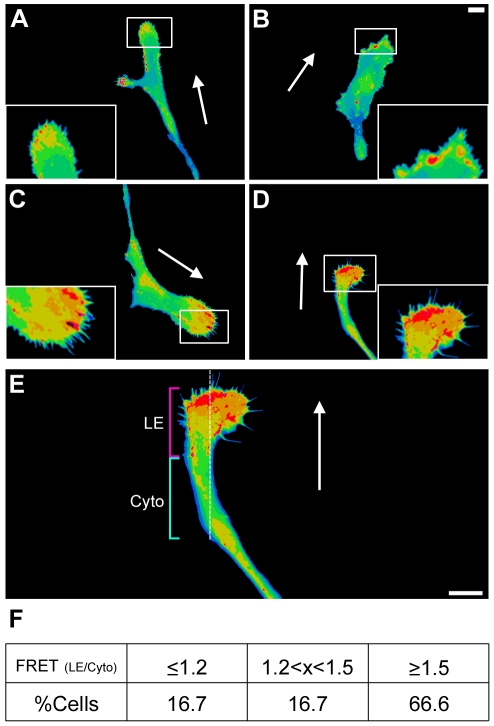
PKA is activated at the leading edge of invading SKOV-3 cells.(A-D) SKOV-3 cells transiently expressing pmAKAR3 were subject to the donut invasion assay and images of cells on the monolayer periphery were acquired 10 h after gasket removal. Pseudocolored FRET images are shown, with insets depicting enlargements of the areas indicated by the white rectangles in each panel. White arrows indicate the direction of invasion with respect to the cell monolayer. Scale bar  = 10 µm. (E, F) To quantify the number of invading cells exhibiting leading edge PKA activity, the average FRET ratio was measured by linescan in the leading edge (LE) and the cytoplasm (Cyto) of cells and a ratio of these values (FRET(LE/Cyto)) was determined. (F) shows the percentage of cells exhibiting low, medium, or high LE/Cyto FRET ratios, as described in Figure 4 (n = 28 from four separate experiments).